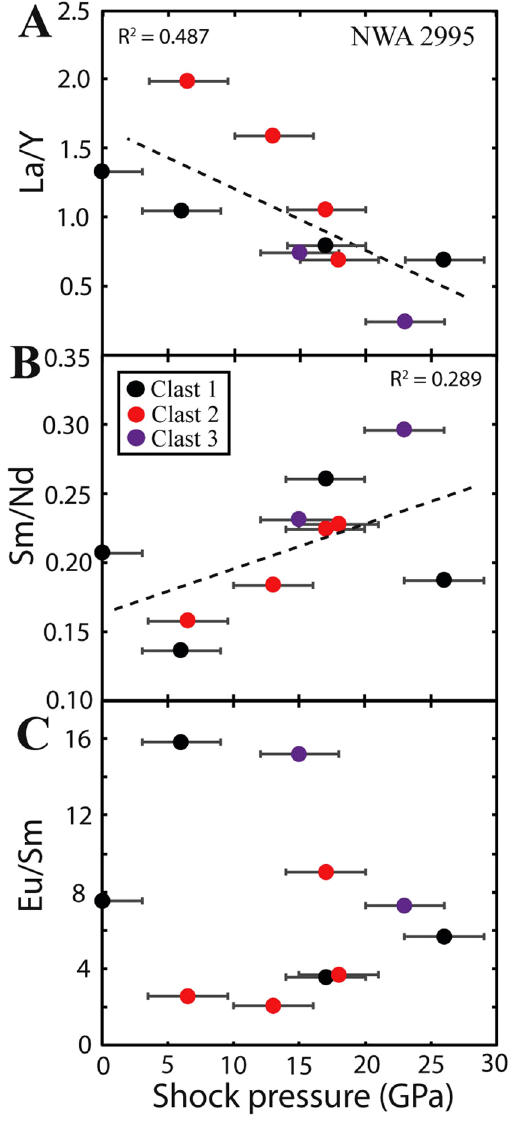
Figure 6. ( A ) La/Y vs. calculated plagioclase peak shock pressure, ( B ) Sm/Nd vs. calculated plagioclase shock pressure (GPa). ( C ) Eu/Sm vs. plagioclase shock pressure (GPa) for FAN fragments within NWA 2995. Best fit lines are plotted for all data points. A weak correlation is observed between Sm/Nd or La/Y and shock states. Error bars represent 1 σ (see SOM for